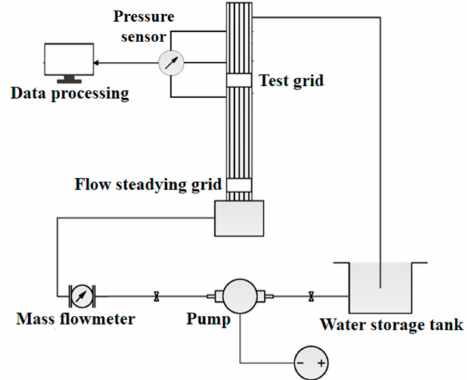
Figure 7. Experimental